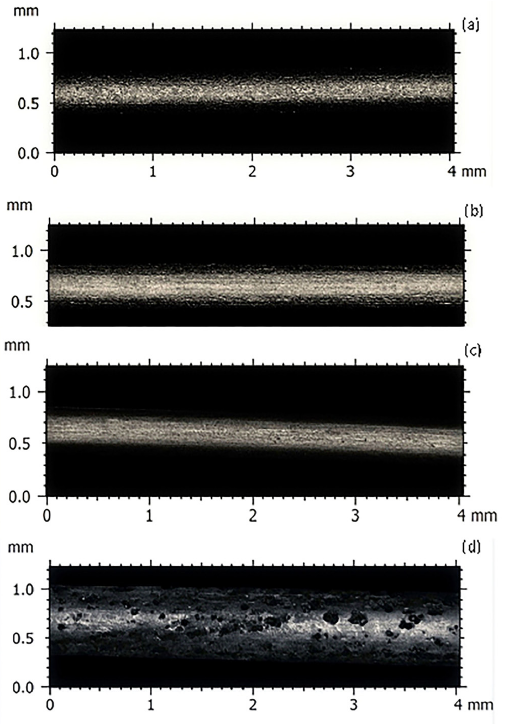
Figure 5. Confocal images of NiTi (a,b) and NiTiCu (c,d) raw material before (a,c) and after (b,d) polarization.